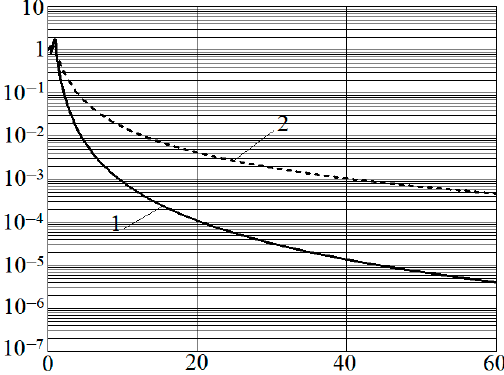
Figure 2. The graph of the dependence of the convective operator approximation error on the number of nodes: 1—for the scheme (13); 2—for the central difference scheme.